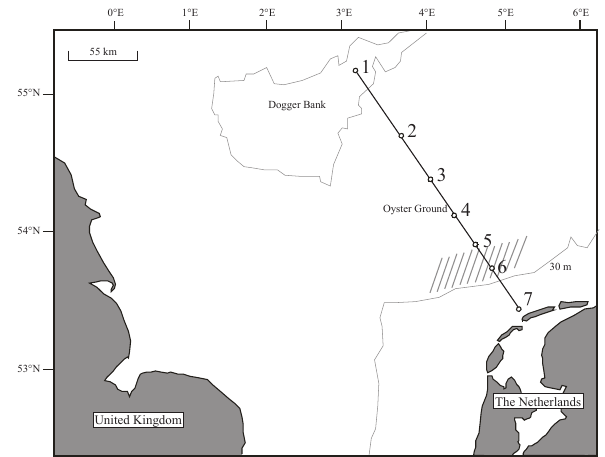
Fig. 1. Map of the southern North Sea showing the study site. Sta- tions are labeled 1–7. Approximate bathometry at 30m illustrated with gray line and approximate area of the Frisian Front indicated with hatched area. Adapted from map in Weston et al.